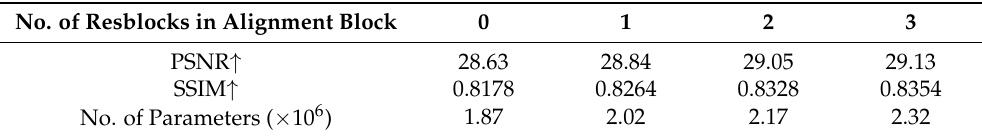
Table 2. Verification tests to determine the optimal number of Resblocks in the alignment block. Each test result shows PSNR (dB), SSIM, and the number of